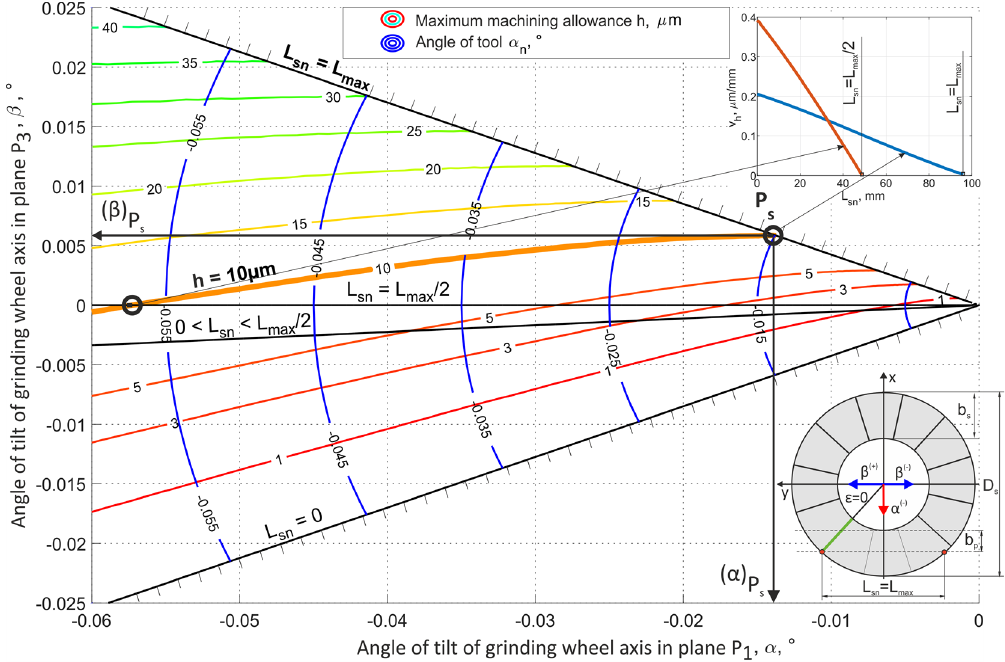
Figure 8. The values of the geometric parameters for the micro-face grinding method using a conical tool; D s = 250 mm, b s = 40 mm, b p = 30 mm.